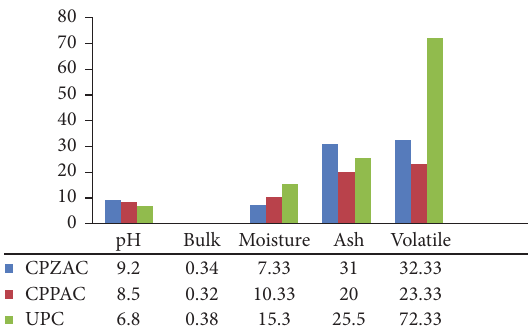
Figure 1: Physical characteristics of carbon